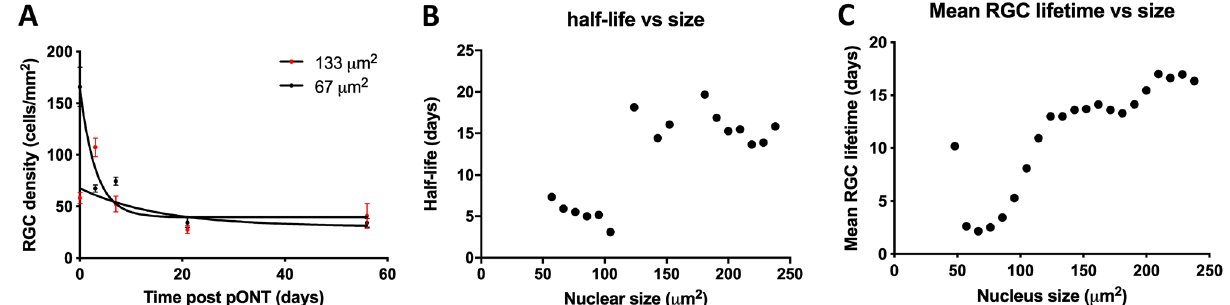
Figure 5. Relationship between nucleus area and rate of loss (half-life) over the course of model. RGC densities binned by nucleus area were plotted over the natural history of the OHT and pONT models before fitting to exponential decay equation ( A ). In both ( B ) OHT and ( C ) pONT models, smaller RGCs typically have shorter half-lives than larger cells, suggesting preferential loss of smaller RGCs from the correlated with primary or secondary degeneration processes, retinas subjected to pONT were spatially seg- mented into superior and inferior quadrants (Fig. 4; Suppl. Fig. 5), from which superior and inferior PDFs were constructed at each time point. As the proportion of primary versus secondary degeneration is different in the superior and inferior retina (with more primary neurodegeneration (due to directly severed axons) in the superior retina and more secondary neurodegeneration in the inferior retina) in the pONT model (Fig. 4F) 22,44 , a difference in PDF between superior and inferior retina may indicate a bias in RGC size and differential suscep- tibility to primary or secondary degeneration. At baseline (Fig. 4B) and 3 days after pONT induction (Fig. 4C) there was no apparent superior/inferior selectivity in the loss of RGCs. A possible explanation for this observa- tion is that during this time, RGCs are lost only by primary degenerative processes that occur shortly after injury. After this time, a noticeable shift in PDF was observed from 7 days post pONT induction, with a greater prob- ability of smaller RGCs being present in the superior than inferior retina. One explanation for this observation is dynamism in the RGC population, either as a result of RGCs shrinking in the superior retina or expanding in the inferior retina in response to injury. Alternatively, this data could be interpreted to suggest that larger RGCs are more susceptible to primary degenerative processes. To resolve these possibilities, RGC density, binned by nuclear size was fit to a single-phase exponential decay model (Eq. 1) to establish the half-life of each RGC subpopulation over the history of OHT and pONT models (Fig. 5). In both OHT (Fig. 5A) and pONT (Fig. 5B) models, smaller RGCs were found to be lost more rapidly than larger RGCs, suggesting that Fig. 4 illustrates a subset of RGCs in the superior retina reducing in size prior to rapid cell loss. Assessing the feasibility of using disease-associated changes in RGC spatial distribution and size as novel diagnostic indicators. Adaptive Optic confocal Scanning Laser Ophthalmoscopy (AO- cSLO) and Detection of Apoptotic Retinal Cells (DARC) represent emerging techniques for the non-invasive visualisation of RGCs in the human retina at the single cell resolution. A limitation of these approaches is the field of view, which presently only permits the visualisation of a few hundred RGCs per image in the case of AO-cSLO. To evaluate whether sampling of the RGC population in this manner can provide sufficient informa- tion (spatial and morphological) to distinguish between glaucoma and naive retina, a bootstrapping approach was employed, whereby retinae were divided into three groups (naive, OHT and pONT) and randomly sampled 100 000 times, in each case using a 0.5 mm 2 rectangular window of observation. A total of four measures were recorded from each observation window: average nearest neighbour distance (NND), regularity index (RI), mean RGC area and mean absolute deviation (MAD) of RGC area. Here, NND is defined as the average distance between each RGC and its nearest neighbour in the retinal mosaic. RI comprises a spatial statistic derived from the frequency distribution of NNDs, and is calculated by dividing the mean NND by the standard deviation of the NND of a population within a sample field. The MAD of RGC area is measure of the variability in a dataset, and is defined as the average distance between each data point and the mean RGC area. Results from OHT and pONT bootstraps were compared to results from naive retina by the construction of ROC curves, and the AUCs were compared. Furthermore, mean differences in OHT and pONT parameters versus naive measures were compared (Figs. 6, 7, respectively). The OHT model, which was the more-mild of the two models investigated, recorded AUCs of 0.69, 0.66, 0.56 and 0.57 for NND, RI, mean cell size and MAD cell size, respectively (Fig. 6). The pONT model by contrast recorded AUCs of 0.93, 0.81, 0.70 and 0.97 for NND, RI, mean cell size and MAD cell size, respectively (Fig. 7). These data suggest that each of these measures may have diagnostic utility in identification of more severe retinal injury. Particularly intriguing is that the latter three measures are independent of RGC density, which is important as variation in the number of RGCs between healthy individuals is well documented 45,46 . Future studies may be able to increase the diagnostic power of this technique by spatially restricting the position of the observation window to a particular region of the retina (i.e. 1 – 1.5 mm from the ONH) or by considering more complex spatial patterns of RGC populations, which may further increase the diagnostic power of this technique. This has important implications for retinal imaging technologies, where wide-field, whole retinal visualization is currently difficult without pupillary dilation and time-consuming approaches. In summary, these data suggest